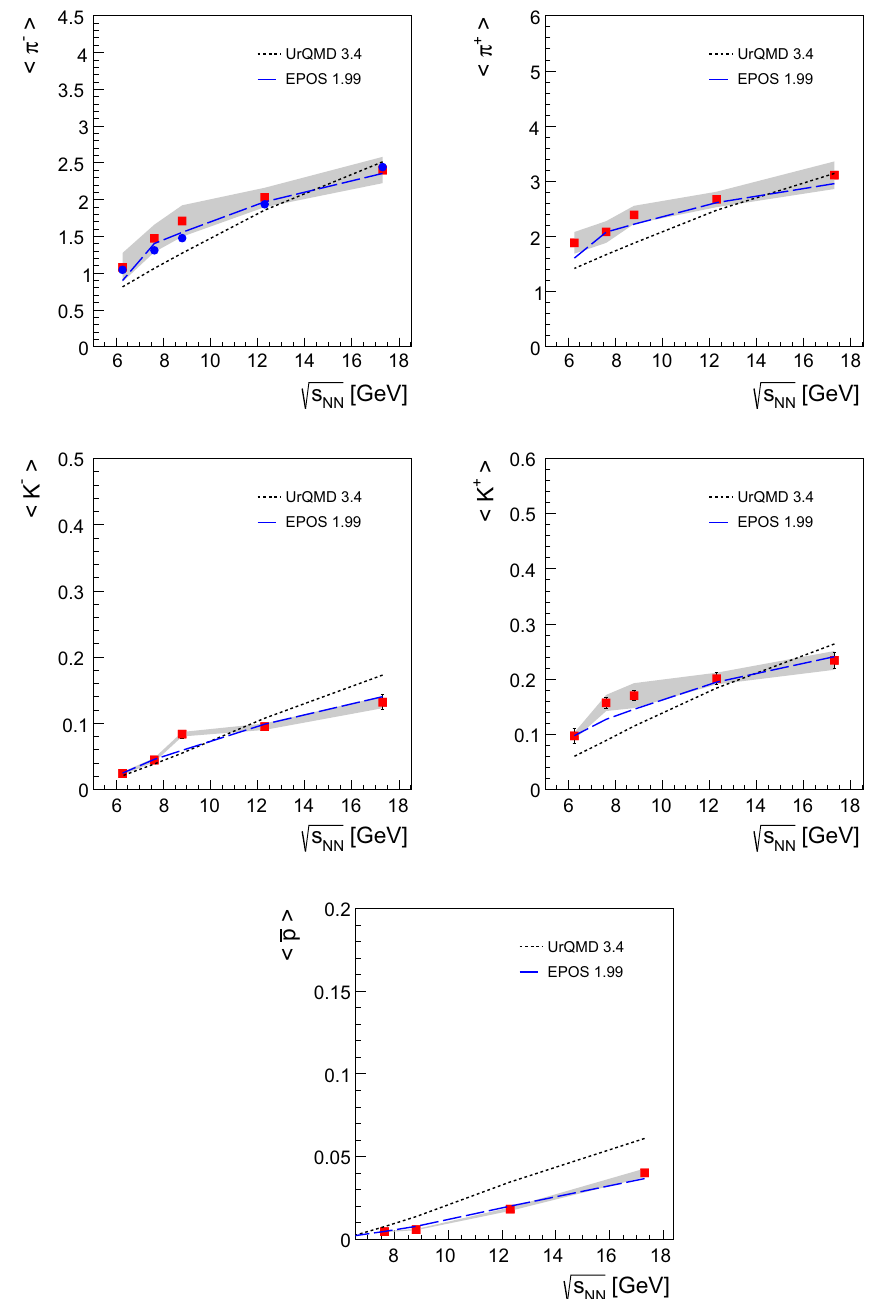
Fig. 34. Statistical uncertainties, indicated by vertical